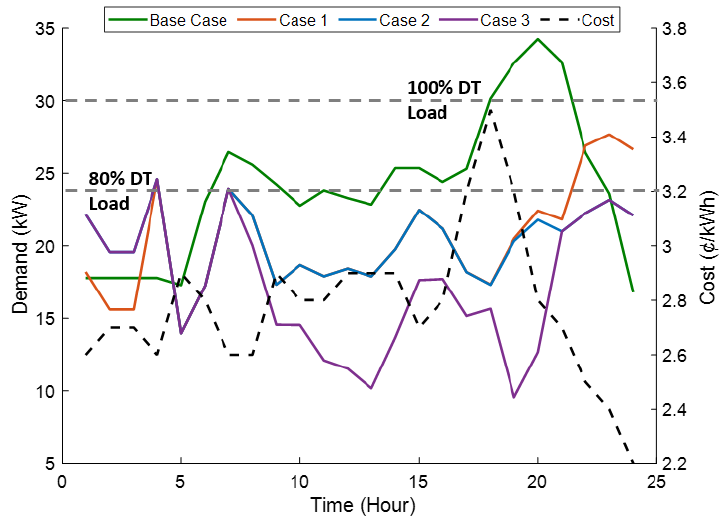
Figure 9. The impact of the DR on distribution transformer load profile.